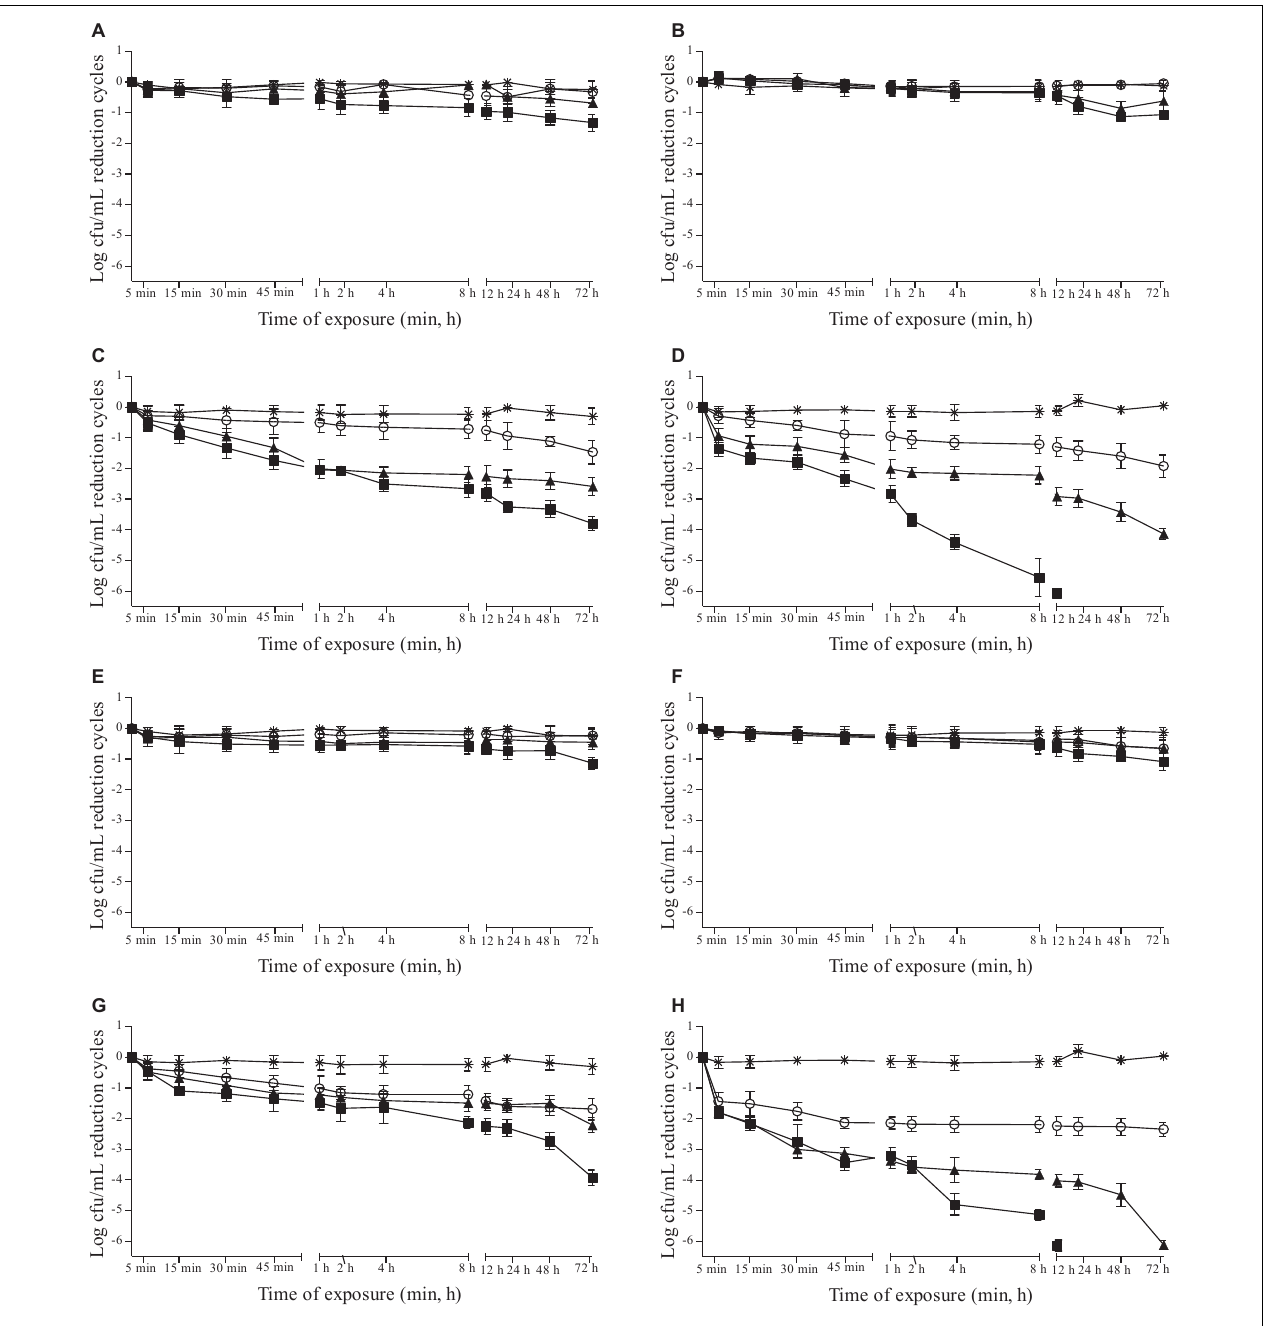
FIGURE 4 | Reduction cycles (log cfu/mL; n = 6) of the counts of C. albicans ATCC 90028 (A,E) , C. tropicalis ATCC 28707 (B,F) , P. anomala ATCC 40101 (C,G) and S. cerevisiae ATCC 2601 (D,H) in pineapple juice at 4 ± 0.5 ◦ C as a function of the concentration of M. spicata L. essential oil (A–D) at ( (cid:4) ): 3.75 µ L/mL, ( (cid:78) ): 1.875 µ L/mL, ( ◦ ): 0.9375 µ L/mL or M. villosa Huds. essential oil (E–H) . ( (cid:4) ): 15.0 µ L/mL, ( (cid:78) ): 7.5 µ L/mL, ( ◦ ): 3.75 µ L/mL, ( ∗ ) control: 0 µ L/mL. Detection limit of the test: 1 log